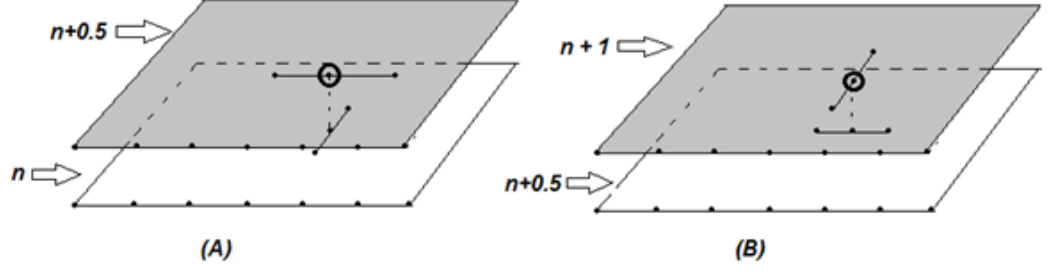
Figure 3. Approximation patterns in the inner points for problems ( A ) and ( B ) . In the left figure for ( A ) —the planes are Ω n , Ω n +1 / 2 ; for ( B ) —the planes are Ω n +1 / 2 , Ω n +1